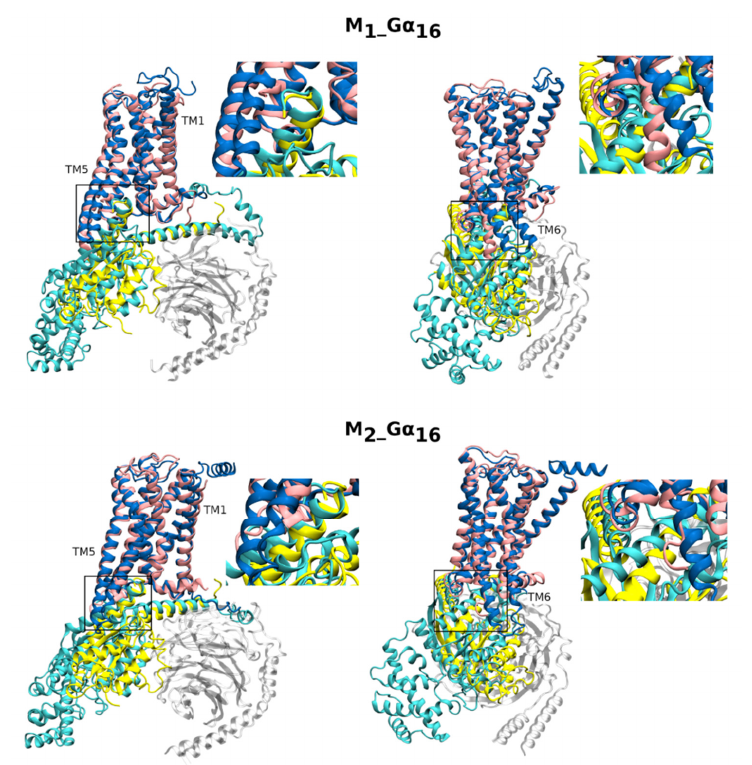
Figure 1. Comparison of homology models of fusion proteins with cryo-EM structures of receptor-G-protein complexes. Comparison of homology models of M 1 _G α 16 (upper, blue_cyan) and M 2 _G α 16 (lower, blue_cyan) fusion proteins with cryo-EM structures of M 1 receptor in an active conformation induced by iperoxo (upper, pink) in complex with G α 11 (upper, yellow) (6OIJ) and M 2 receptor in an active conformation induced by iperoxo (lower, pink) in complex with G α oA (lower, yellow) (6OIK) as viewed TM4 and TM5 (left) or TM6 and TM7 (right) in front. Complexes of βγ -subunits of G-proteins from cryo-EM structures are shown in grey. Structures were aligned on the receptor molecule. Details of insertion of C-terminus of α -subunit into G-protein binding site of the receptor are enlarged in the insets. 2.1.3. Affinity of [ 3 H]NMS for G α 16 Fused Receptors To confirm that fusion with G α 16 indeed did not influence receptor conformation as indicated by molecular modeling, we measured the binding of radiolabeled [ 3 H]NMS to all G α 16 _fused receptors. The affinity of [ 3 H]NMS to fusion proteins was determined in saturation binding experiments and calculated according to Equation (1). The fusion of muscarinic receptors with G α 16 subunit did not affect the binding affinity of [ 3 H]NMS at any fusion protein. The determined affinity of [ 3 H]NMS to fused and wt receptors, as well as their expression level in CHO cells, is summarized in (SM Table S1). 2.2. Lack of Coupling of G α 16 _Fused Receptors with Endogenous G-Proteins Muscarinic receptors are able to activate multiple G-proteins. Preferentially, musca- rinic receptors M 1 , M 3 , and M 5 couple with G α q/11 and M 2 and M 4 receptors with G α i/o G- proteins. All muscarinic subtypes efficiently activate non-canonical promiscuous G-pro- tein (G 16 ) followed by activation of the appropriate signaling pathway (phospholipase C-